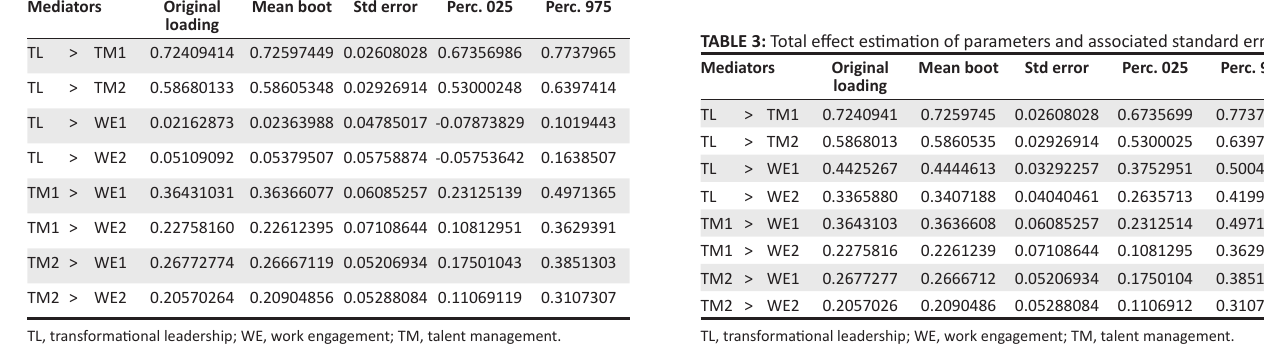
TABLE 2 : Direct relationship estimation of parameters and associated standard errors. Mediators